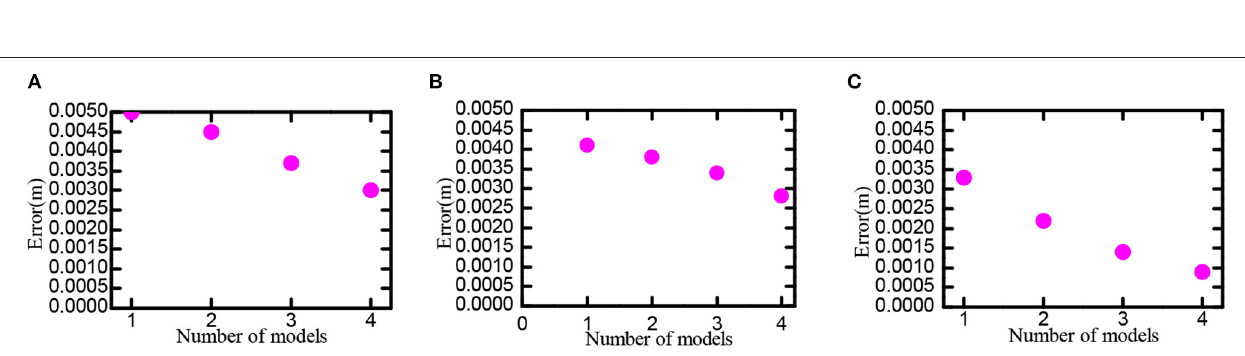
Frontiers in Neurorobotics | www.frontiersin.org 9 January 2022 | Volume 15 | Article